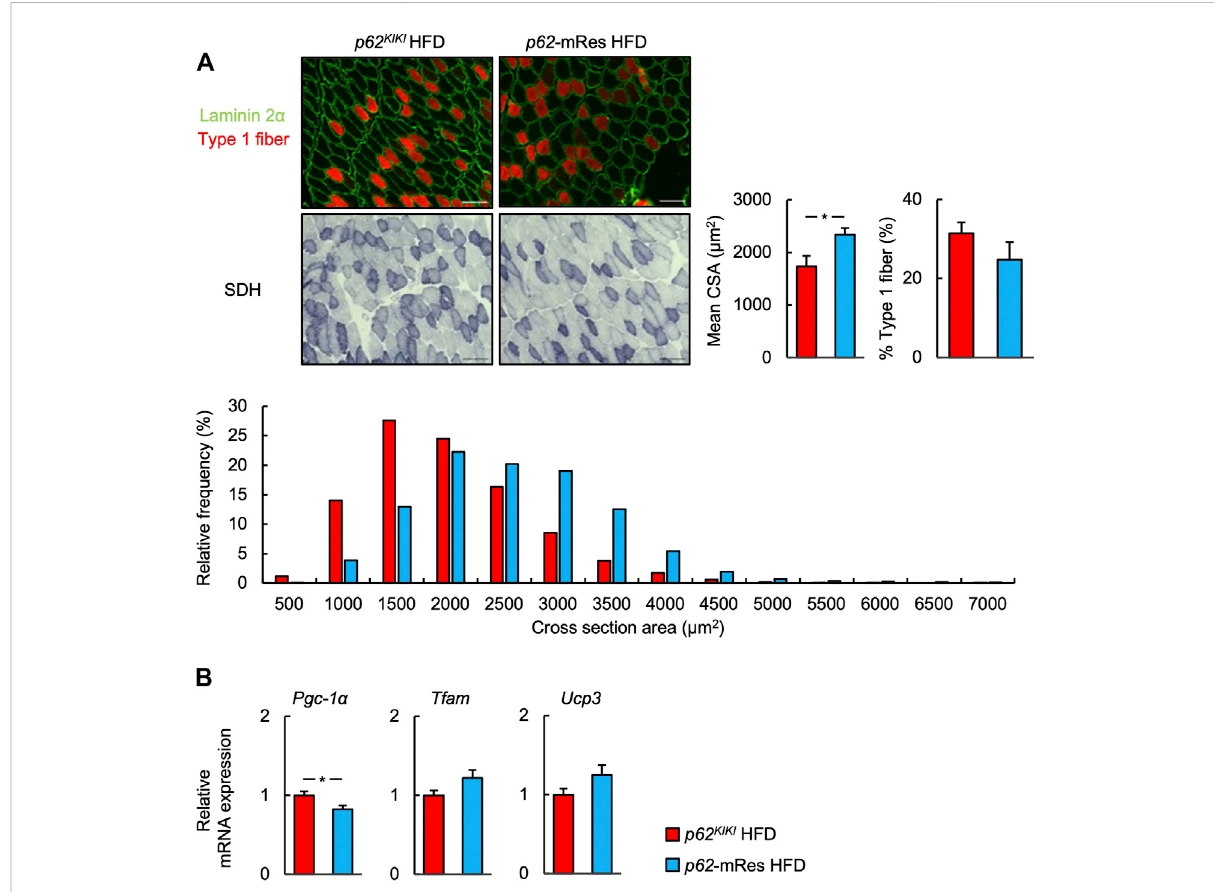
FIGURE 3 p62inmuscleincreasesmuscleskeletalmuscle fi bersize. (A) Representativeimagesof fl uorescenceimmunostainingforlaminin2 α (green)and slow myosin heavy chain (type 1 fi bers, red), and succinate dehydrogenase (SDH)-stained sections of tibialis anterior muscles from 25-week-old p62 KIKI and p62 -mRes mice fed an HFD. Scale bars represent 100 μ m. Skeletal muscle fi ber cross-sectional area (CSA), percentage of type 1 fi bers, and skeletal muscle fi ber CSA distribution histograms for 25-week-old p62 KIKI and p62 -mRes mice fed an HFD ( n = 4 – 5/group). (B) mRNA expression of mitochondria-related genes ( Pgc-1 α , Tfam , and Ucp3 ) by qPCR analysis ( n = 8/group). Values are mean ± SEM. * p < 0.05 (unpaired t